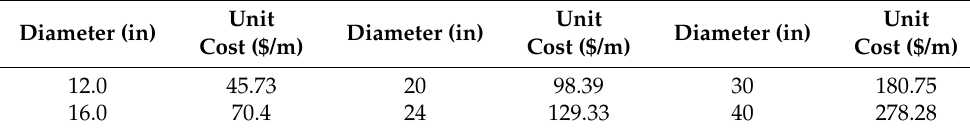
Table 2. Diameter options and associated unit costs for Hanoi WDS.